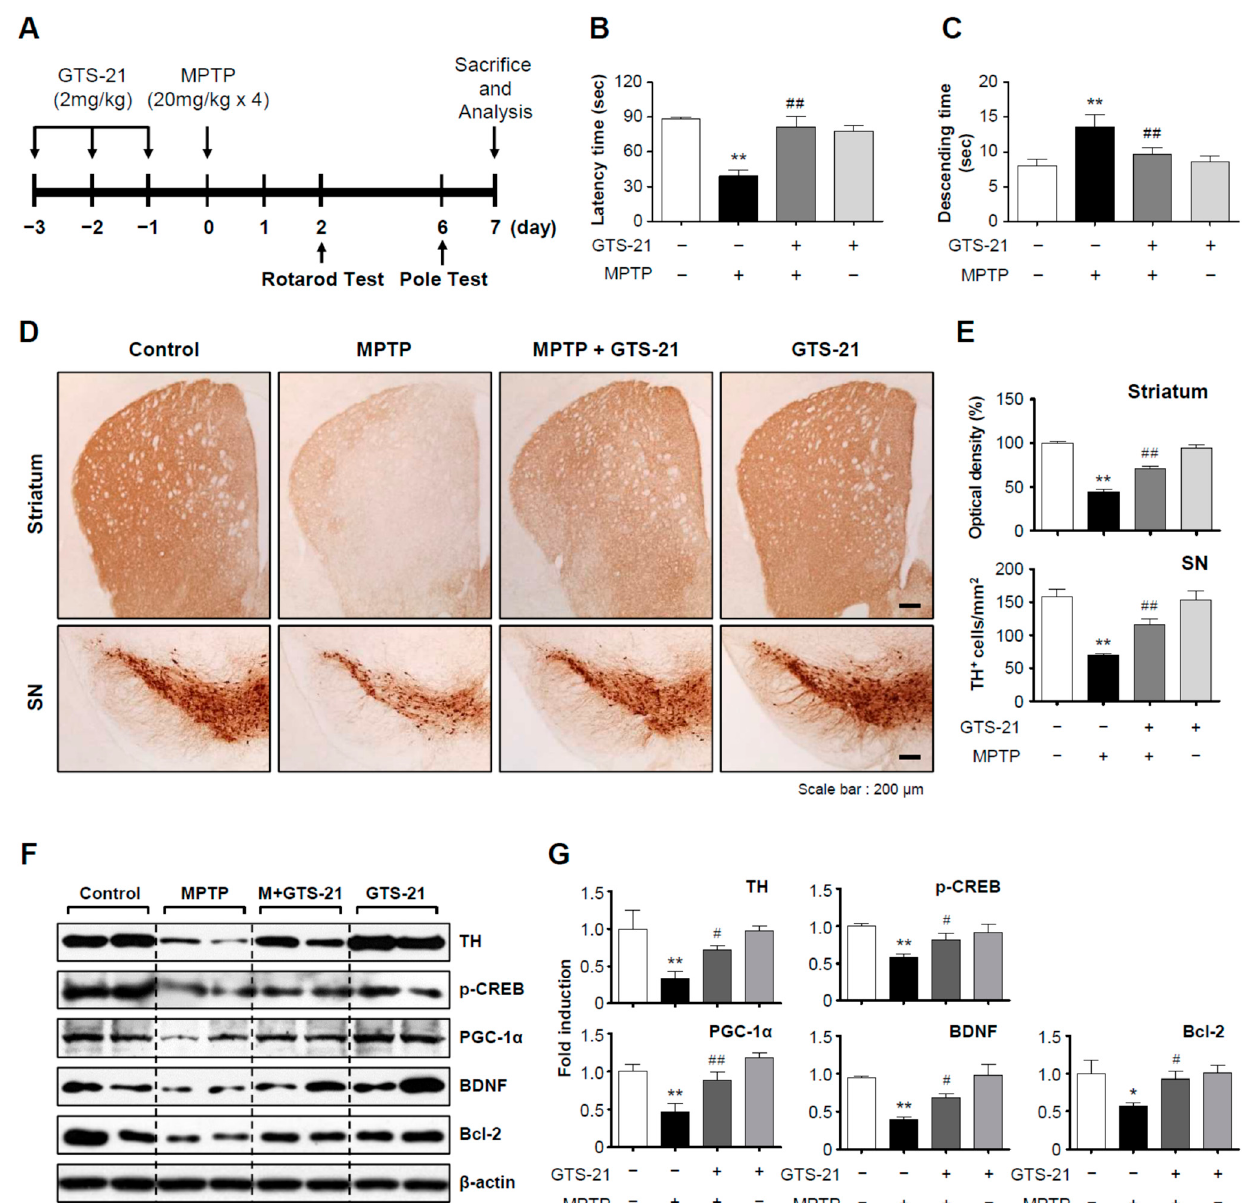
Figure 7. GTS-21 ameliorated the impaired movement and dopaminergic neuronal cell death in the brains of MPTP-injected mice. ( A ) The experimental procedure is depicted schematically. Mice were given GTS-21 (2 mg/kg, i.p.) daily for three days prior to MPTP injection. Mice were sacrificed 7 days after MPTP injection for histological and biochemical analyses. ( B , C ) The rotarod and pole tests were carried out two and six days after the MPTP injection, respectively ( n = 8–9 per group). ( D , E ) TH-positive neuronal cells in the substantia nigra and striatum (representative pictures) ( D ). The optical density of TH-positive fibers in the striatum and the number of TH-positive cells in the substantia nigra were measured for quantitative analysis ( E ) ( n = 4 per group, 3 sections/brain). ( F , G ) Protein extracts from the substantia nigra of each group were analyzed using TH, p-CREB, PGC-1, BDNF, and Bcl2 antibodies ( n = 4). The figures show representative blots ( F ) and quantification data ( G ). The data are presented as the mean ± SEM. * p < 0.05, vs. control group; ** p < 0.01, vs. control group; # p < 0.05 vs. MPTP-treated group; ## p < 0.01 vs. MPTP-treated group.